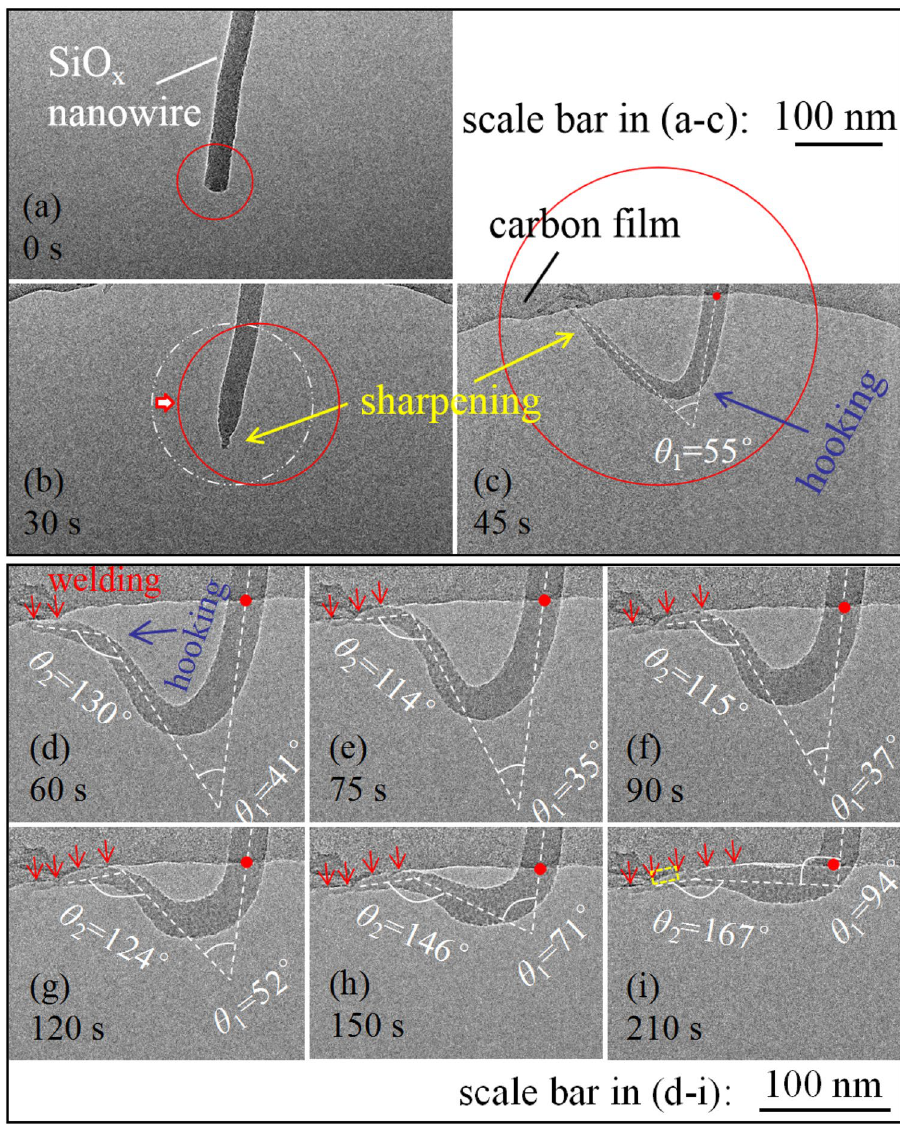
Fig. 1 TEM images showing the sharpening and hooking of a free-ended SiO nanowire x and the subsequent welding to the supporting macroporous carbon film under designed e-beam